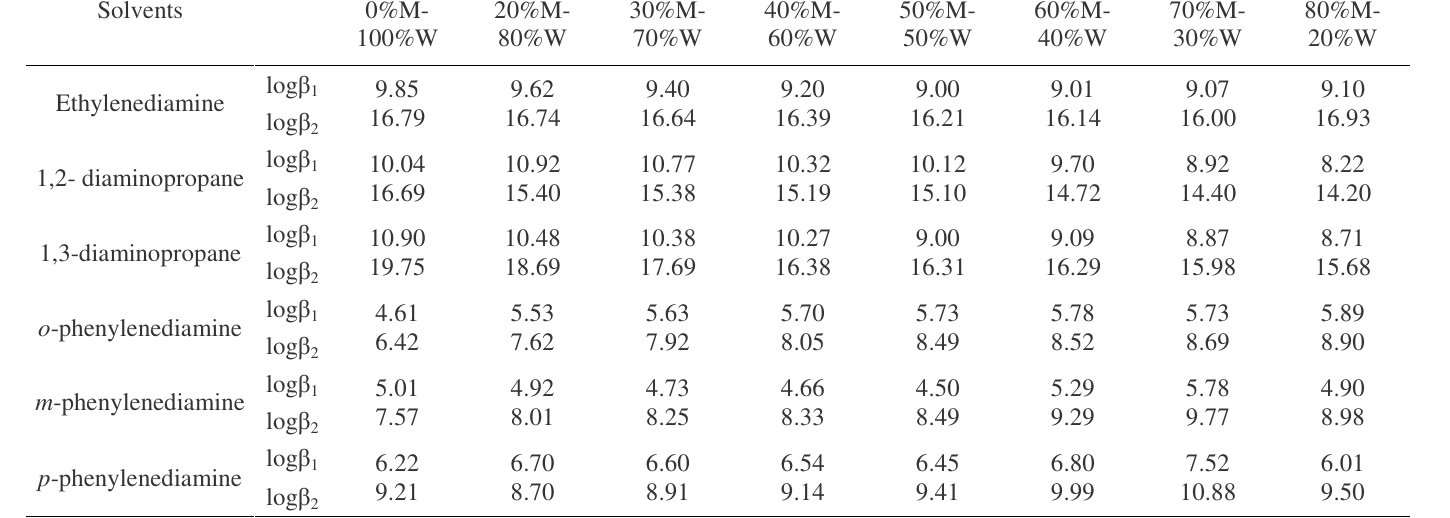
Table 1. Stoichiometric Protonation Constants (log β ) of Some Diamines at 30 + 0.1 o C for different Methanol-Water Mixtures. (µ = 0.2M NaClO 4